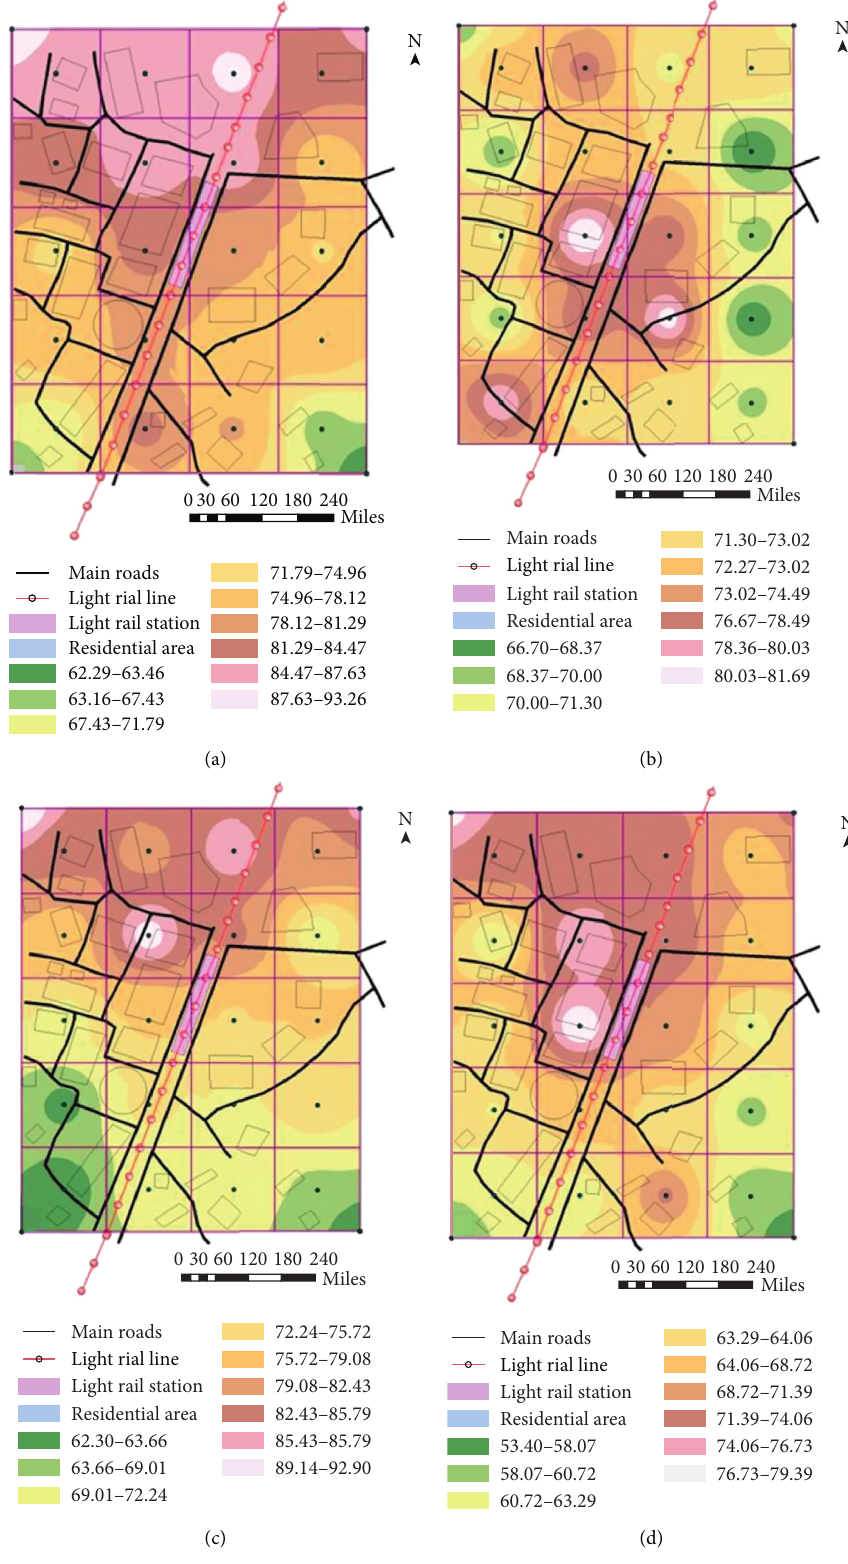
Figure 11: The acoustic environment for Monday. (a) 7:00 a.m. (b) 12:00 p.m. (c) 06:00 p.m. (d) 10:00